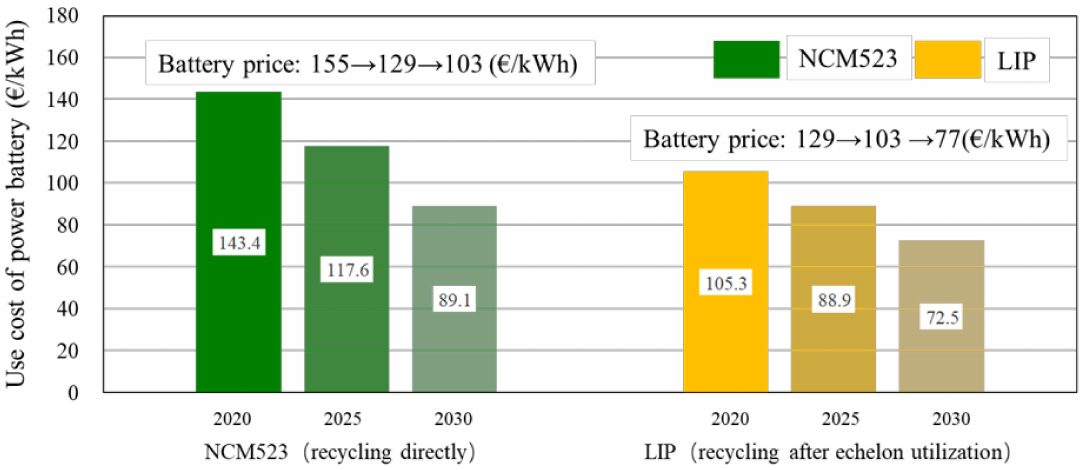
Figure 11. The use costs of di ff erent power batteries with the battery prices